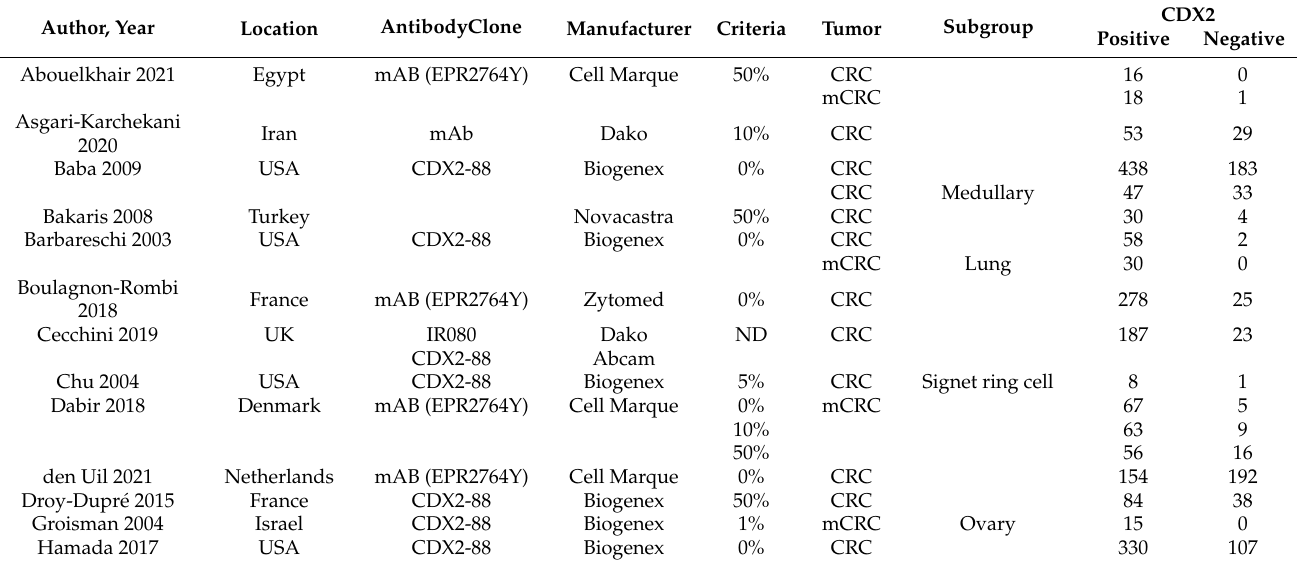
Table 1. Main characteristics of eligible